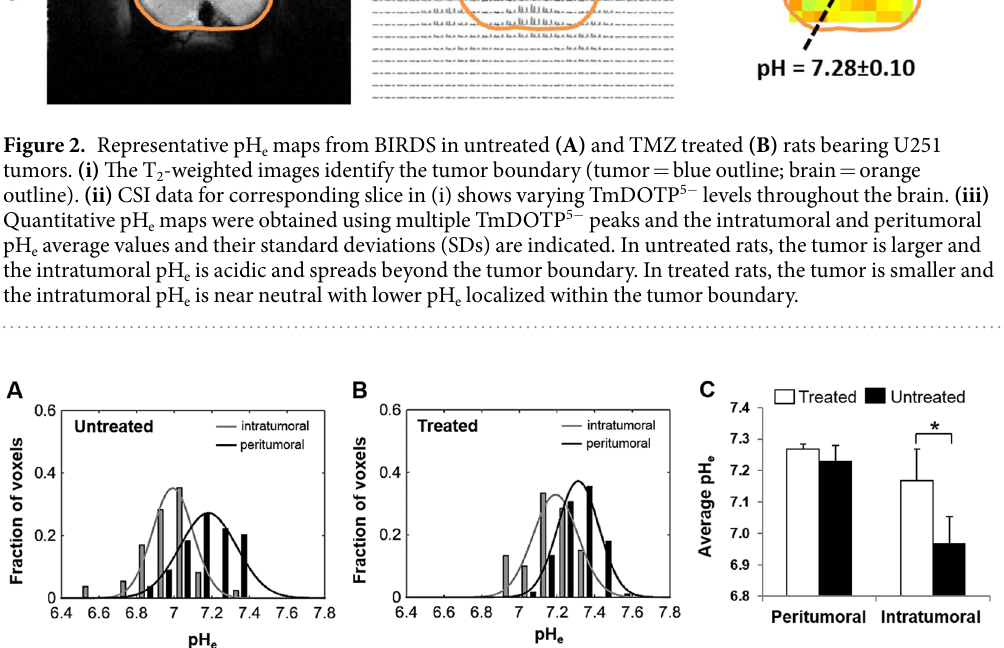
pH e and the full width at half maximum (FWHM) of these histograms. The most probable intratumoral pH e val- ues were higher in treated when compared to untreated tumors. The FWHM values of untreated tumors (~0.4) were higher than treated tumors (~0.3), indicating heterogeneous pH e in untreated rats, which is normalized by TMZ in treated rats. Figure 3C shows the average values of intratumoral and peritumoral pH e in treated and untreated rats. Average intratumoral pH e was significantly (p < 0.01) lower in untreated rats compared to treated rats, whereas in peritumoral regions, no significant difference (p > 0.05) was observed between the two groups. To investigate how pH e is affected in voxels positioned at different distances relative to the center of mass of the tumor, the brain was separated into regions of interest (ROIs) starting from the center of the tumor and pro- gressing outwards in concentric 1 mm circles (Fig. 4A). The boundaries between the intratumoral and the peritu- moral regions (shown with white and black arrows for the treated and untreated groups, respectively, in Fig. 4B) were calculated from the average tumor volume obtained from the anatomical MR images (Fig. 1B), assuming a spherical tumor shape. Lower pH e values were observed in the intratumoral regions (ROIs 1 and 2) in the untreated group (Fig. 4B). In the treated group, the pH e values in the intratumoral regions (ROI 1) were partially